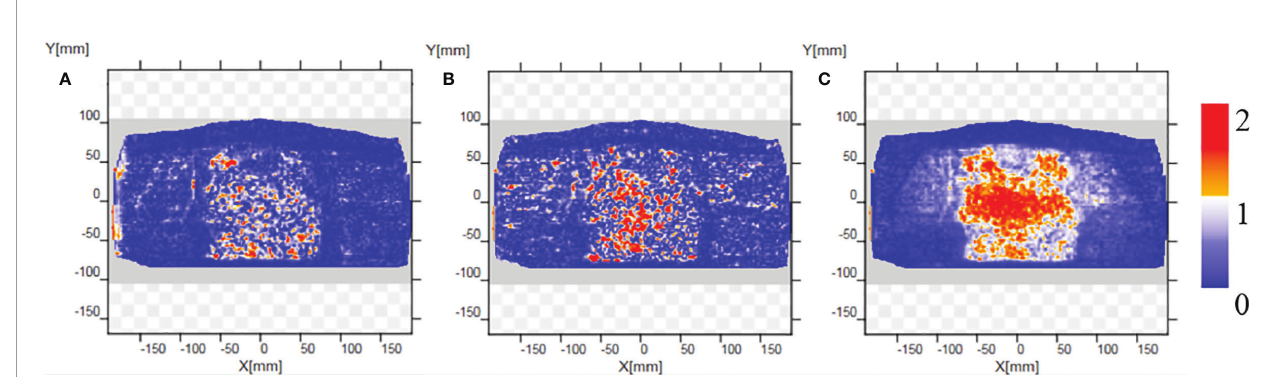
FIGURE 10 | Comparison results of g analysis (2%/2 mm) between the radiotherapy plan based on three types of pseudo-CT images and the radiotherapy plan based on CT gt images. The bluer the dots in the difference map, the smaller the dose difference between the two plans, and the higher the overall g -pass rate. (A) The pass rate graph of gamma analysis based on CT CycleGAN. (B) The pass rate graph of gamma analysis based on CT unet-GAN. (C) The pass rate graph of gamma analysis based on CT